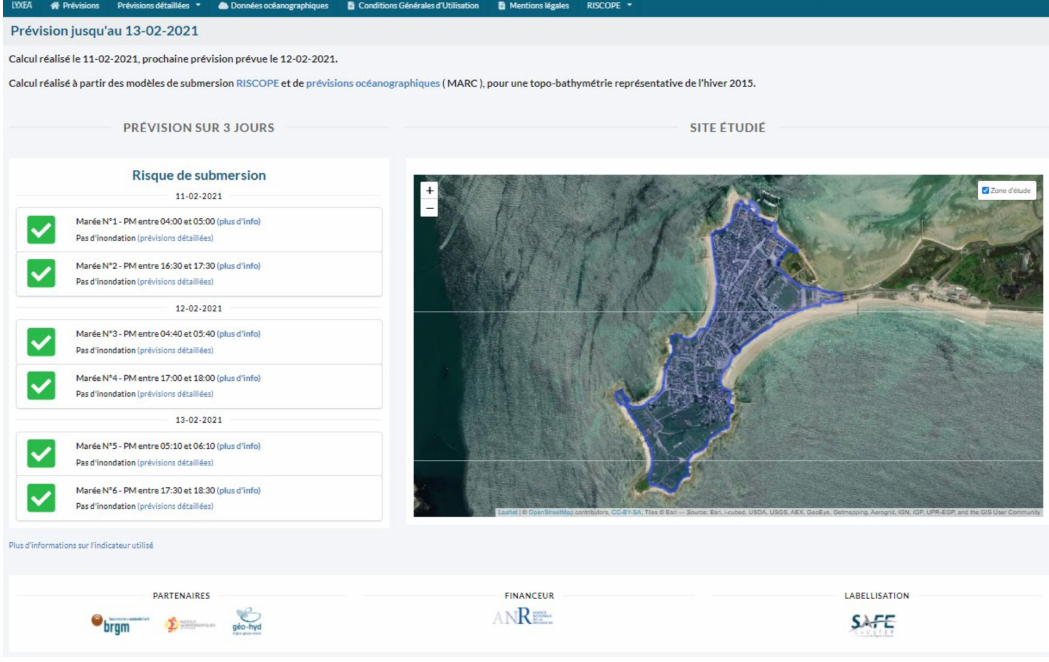
Figure A5. Screen capture of the FEWS webpage synthesising predictions for the six next high tides. The left panel shows the results of the I 1 indicator (shown in green here, as no flood is predicted).